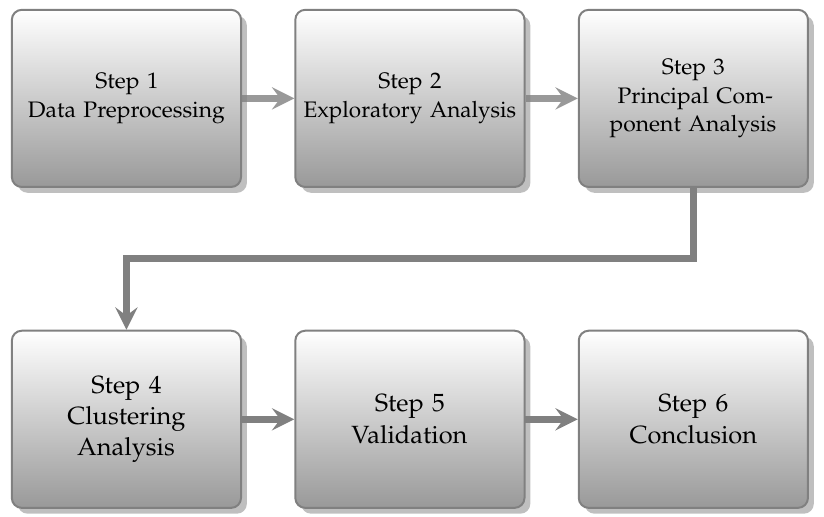
Figure 1. Framework of the analysis